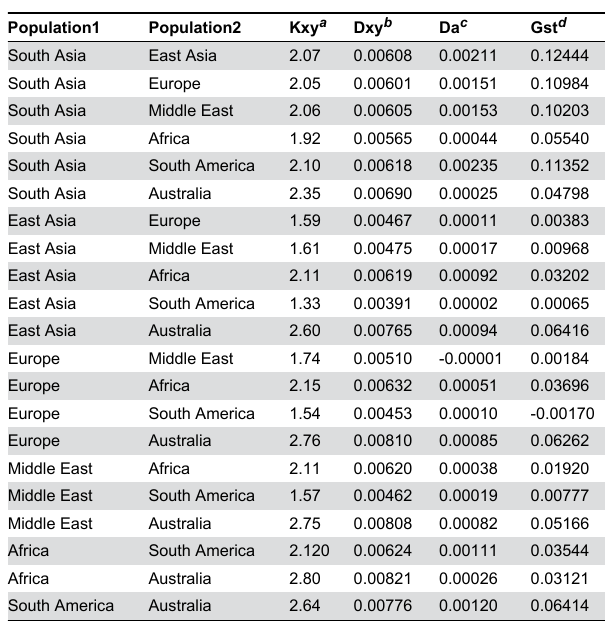
(Table 2). Haplotype diversity (Hd) for all the 369 sequences was calculated to be 0.799 +/- 0.017 SD. Average number of nucleotide differences, k was found to be 1.82 and nucleotide diversity (π) was 0.0053 +/- 0.0002. Haplotype and nucleotide diversity indices were highest in Australian population followed by African population and lowest in South Asian population.